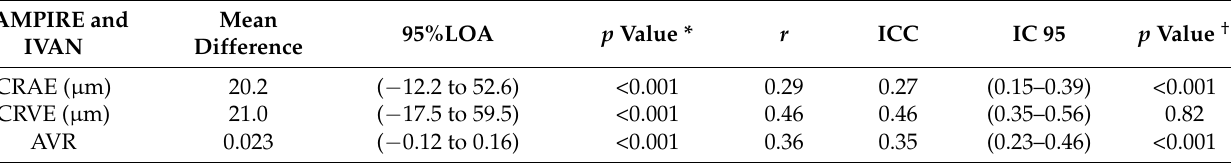
Table 3. Agreement between software applications according to retinal vessel parameter. * p value of one-sample t tests comparing mean difference and zero (systematic bias). † p value of Pearson’s correlation coefficients of the regression line (proportional bias). r , Pearson’s correlation between the parameter values obtained with the two software applications considered. AVR: arteriole-to-venule ratio, LOA: limits of